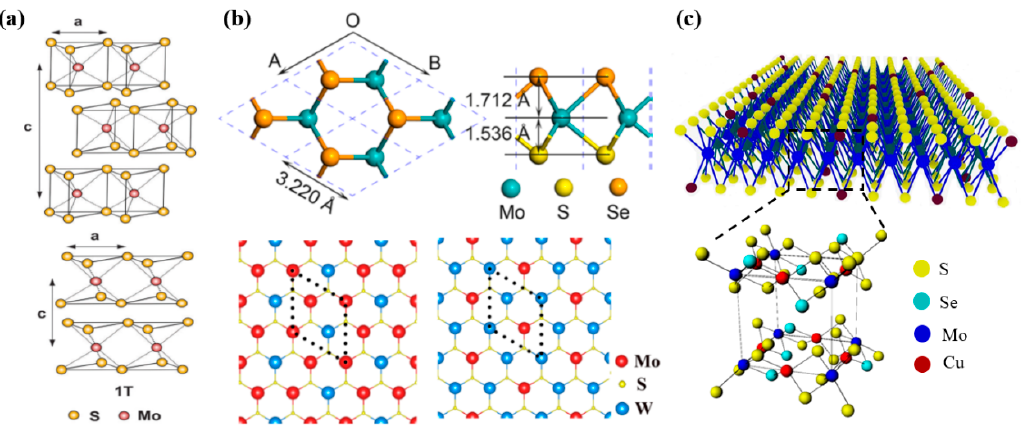
Figure 2. ( a ) Schematic illustration of the 2H-type structure of binary MoS 2 and 1T-type structure of binary MoS 2 . Reprinted with permission from Reference [52], copyright (2013), Royal Society of Chemistry. ( b ) Top and side views of the optimized geometry of two anion contains ternary MoSSe and atomic structures of two cation contains ternary Mo 1 − x W x S 2 atomic structures. Reprinted with permission from Reference [62], copyright (2018), American Chemical Society and Reference [63], copyright (2017), Scientific Reports. ( c ) Layered and crystal structure of quaternary Cu 2 Mo(S 1 − y Se y ) 4 . Reprinted with permission from Reference [64], copyright (2016), Elsevier.